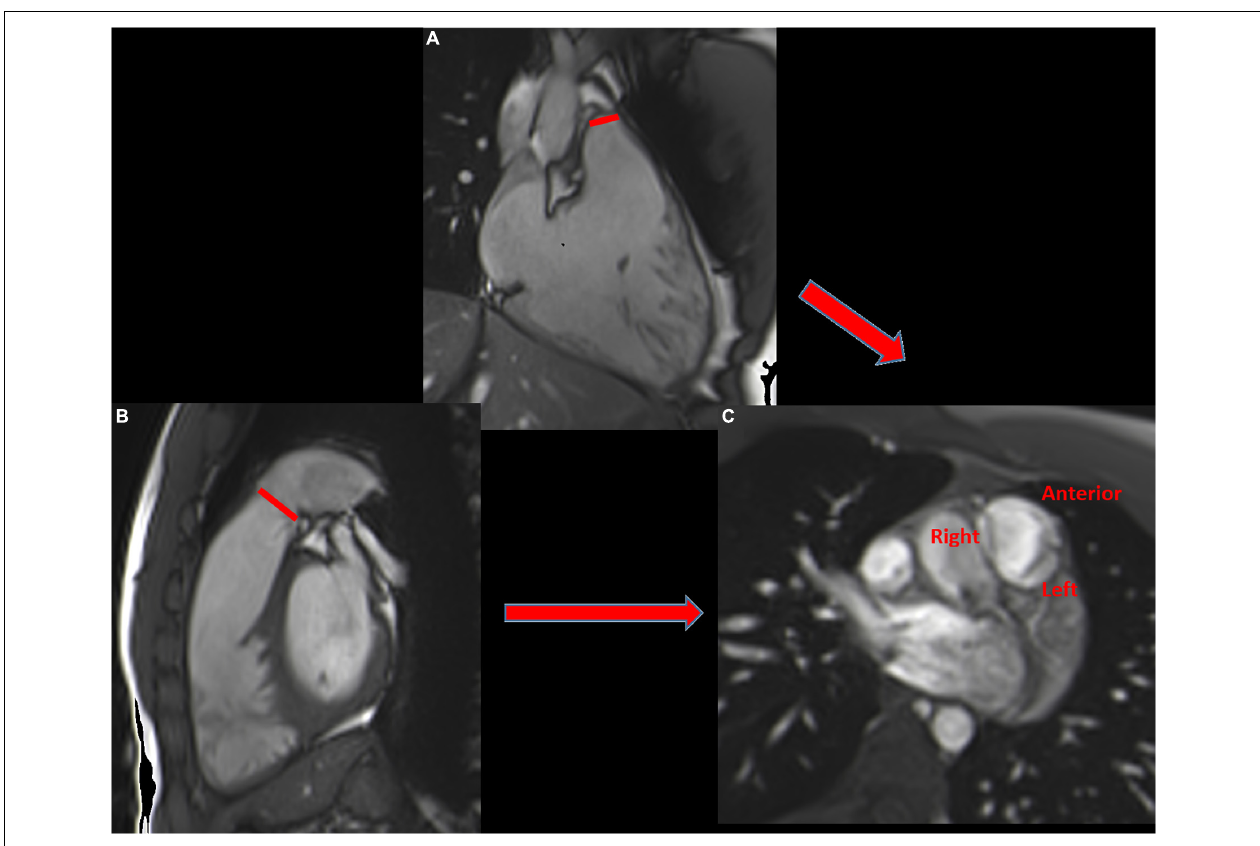
FIGURE 8 | The 3-chamber view (A) and the RVOT (B) allowing the visualization of the three pulmonary leaflets (anterior, left and right) (C)